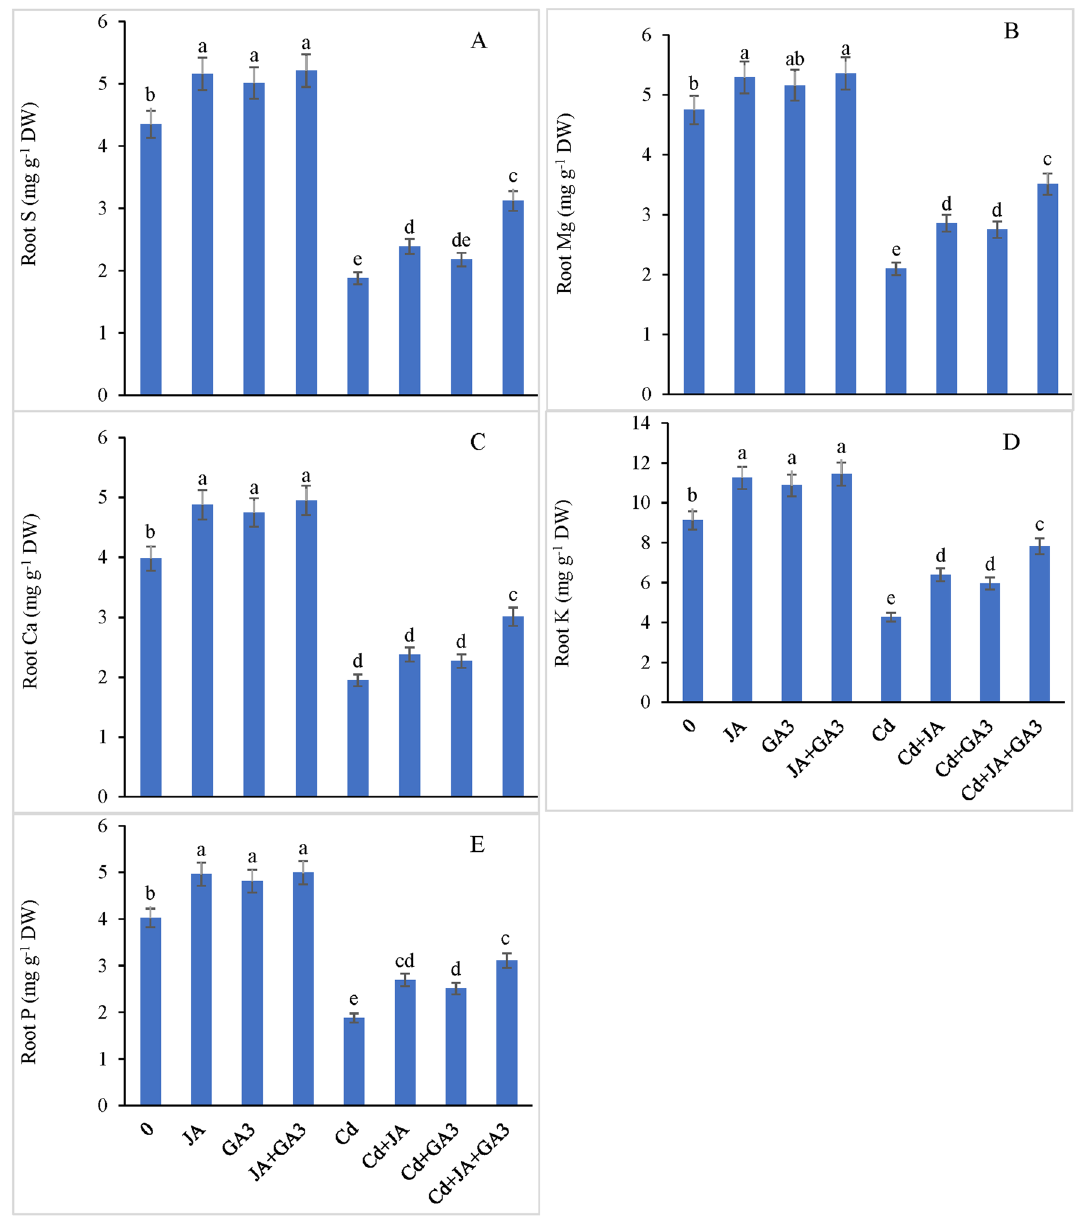
Figure 7. External supplementation of JA and GA 3 individually and/or in combination restored the root mineral elements, ( A ) sulfur (S), ( B ) magnesium (Mg), ( C ) calcium (Ca), ( D ) potassium (K), and ( E ) phosphorus (P) in Cd-stressed chickpea plants (Mean ±